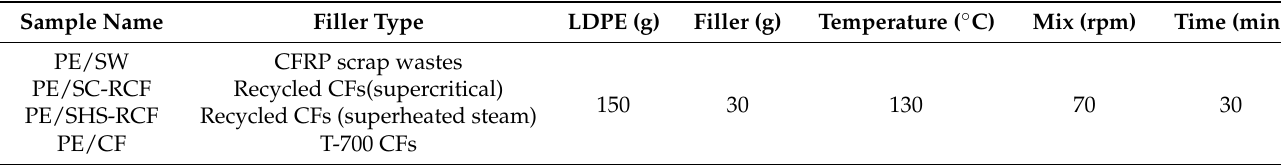
Table 3. CFRP formulation for composite